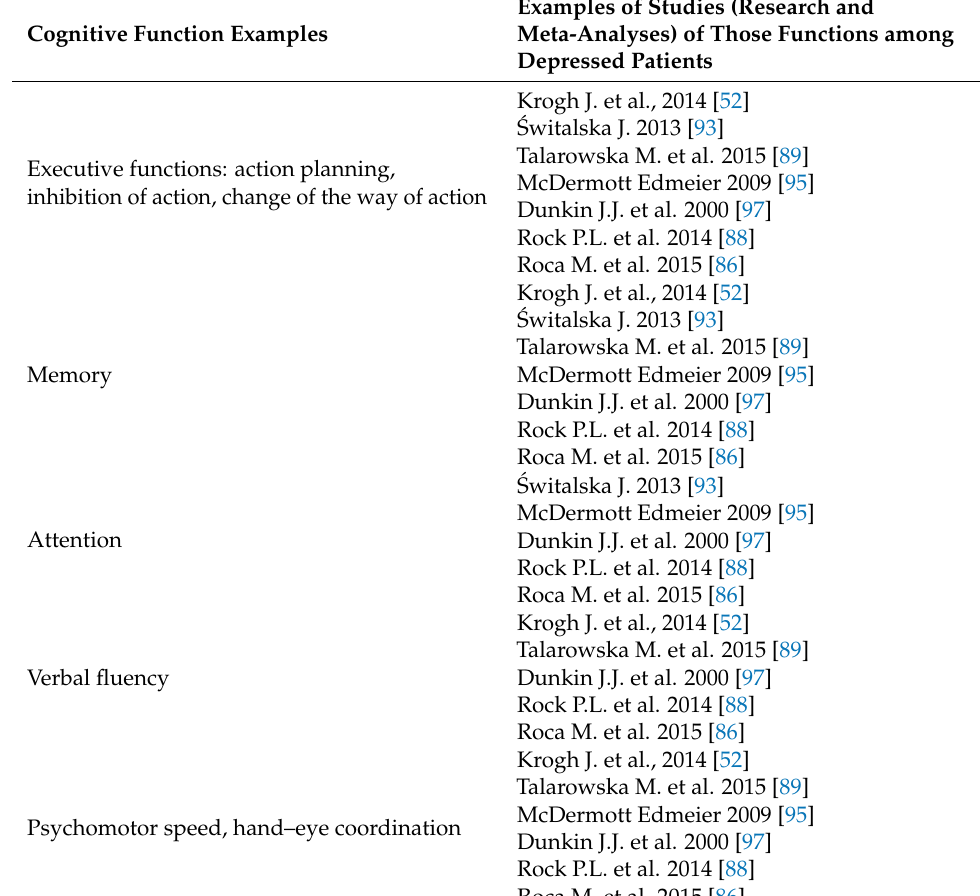
Table 4. Examples of research papers and meta-analyses of cognitive functioning among patients suffering from